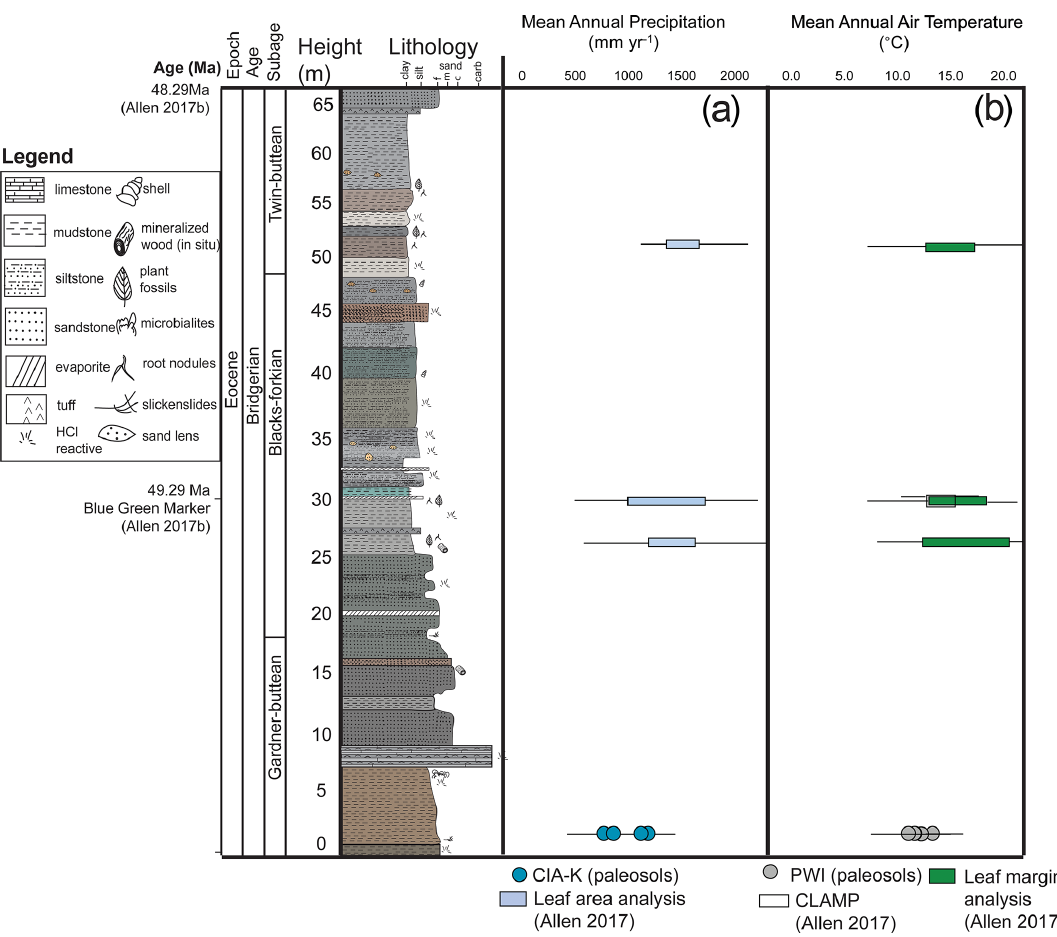
Figure 6. Stratigraphic column with climate proxies. (a) Reconstructed mean annual precipitation (mmyr − 1 ) and (b) mean annual air temperature ( ◦ C). The boxes are ranges reconstructed for physiognomic proxies, and the circles are values reconstructed using paleosols. The lines for both are established errors for the proxies used based on the initial proxy calibrations. Errors were calculated for each estimate, and the error bars span the total range of calculated error. More information on error can be found within these proxy calibrations (e.g., Wilf, 2000; Sheldon et al., 2002; Spicer et al., 2009; Gallagher and Sheldon,